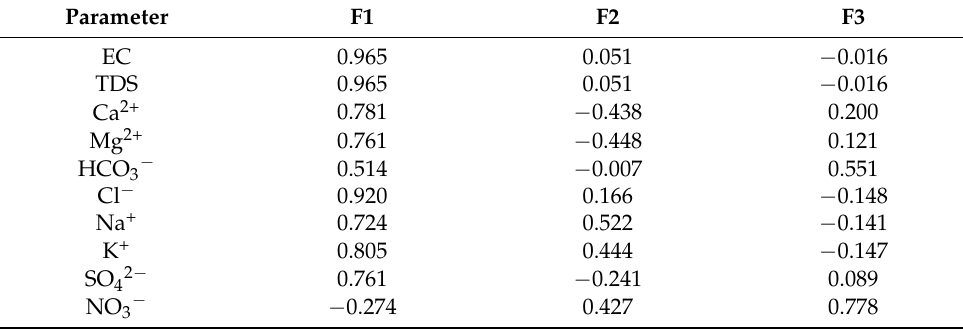
Table 4. Statistical analysis and classes of